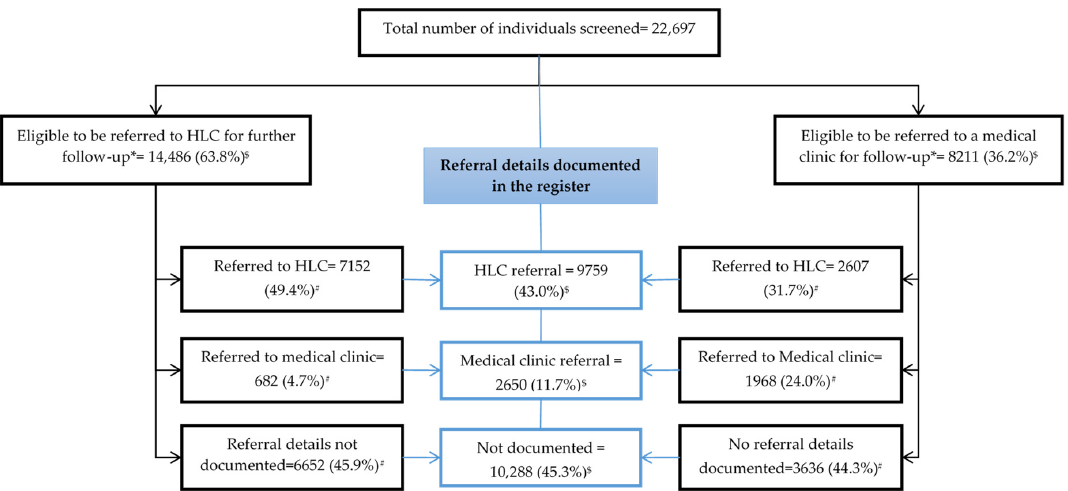
Figure 3. Eligibility for referral and referral status among the individuals screened for NCD risk factors in the selected PMCIs supported by the PSSP in Sri Lanka from June 2019 to May 2021. * Individuals with either “high BP”, “high blood glucose”, “high creatinine”, or 10 year CVD risk ≥ 30% were eligible for referral to medical clinic post screening, and those not eligible to be referred to medical clinic were considered eligible for referral to HLC; $ percentage calculated with total screened as denominator; # percentage calculated with eligible as denominator. Abbreviations: PMCI—primary medical care institution; NCD—noncommunicable diseases; PSSP—Primary Healthcare System Strengthening Project.